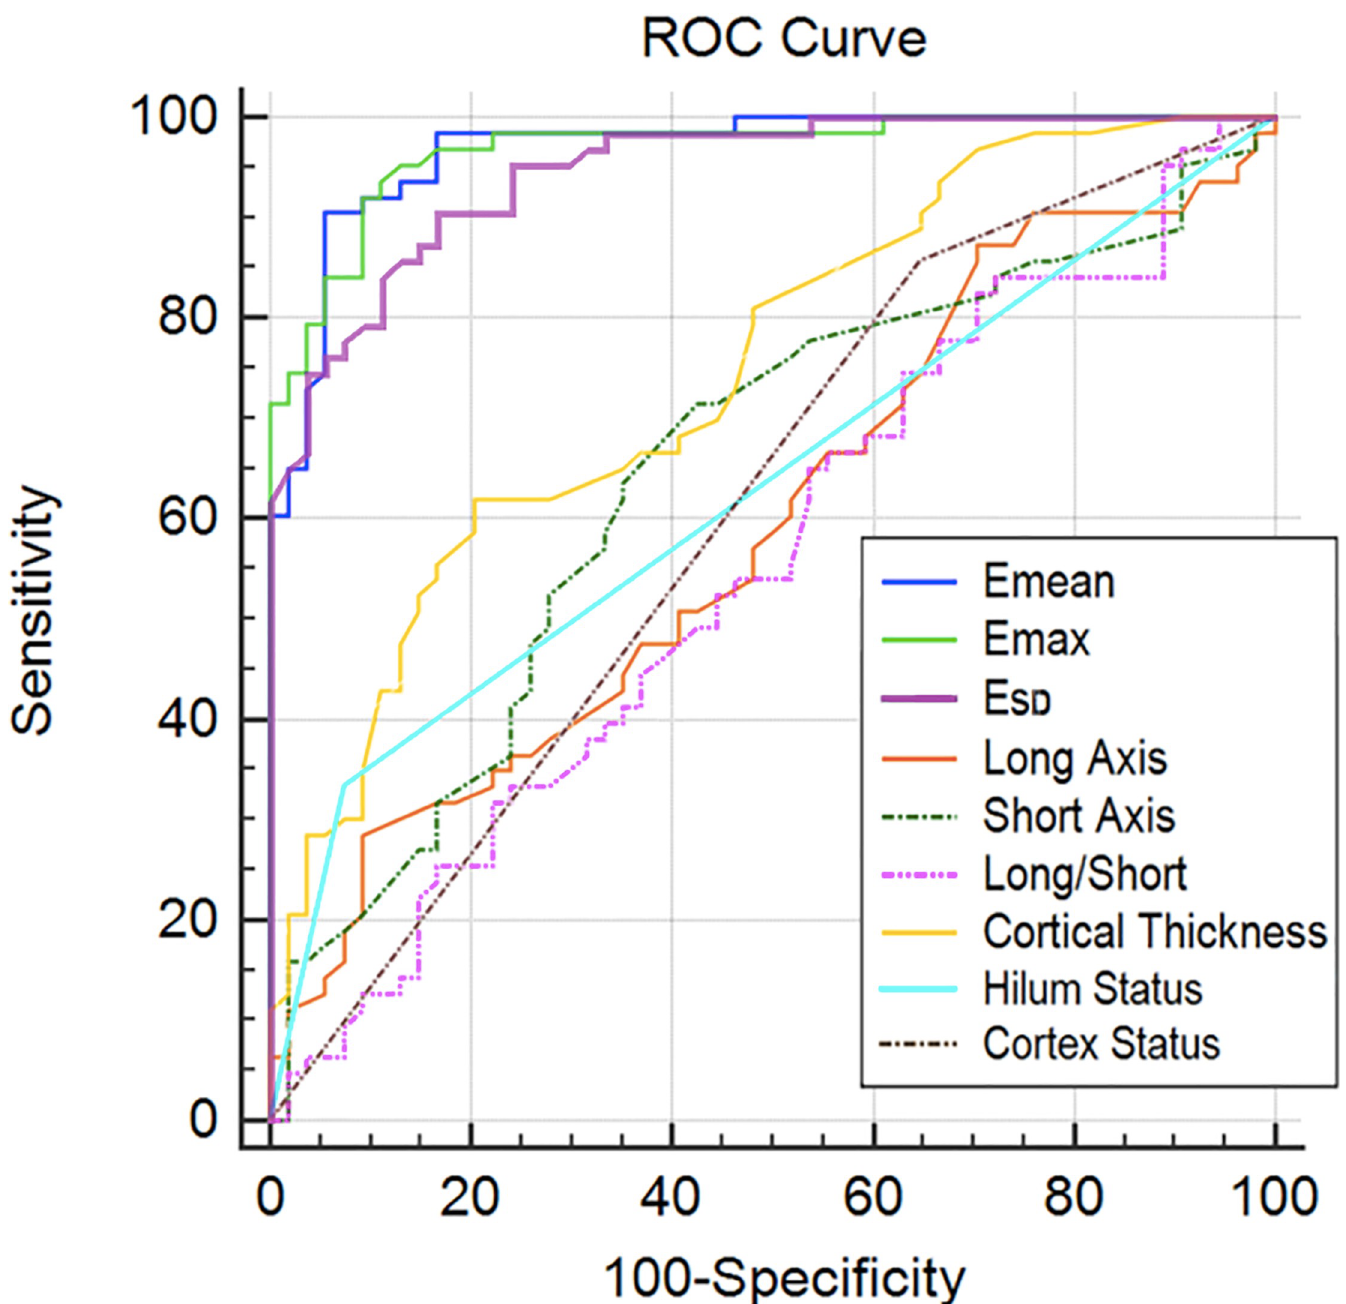
Fig 3. Receiver operating characteristic (ROC) curves of conventional ultrasound features and CUSE elasticity parameters.